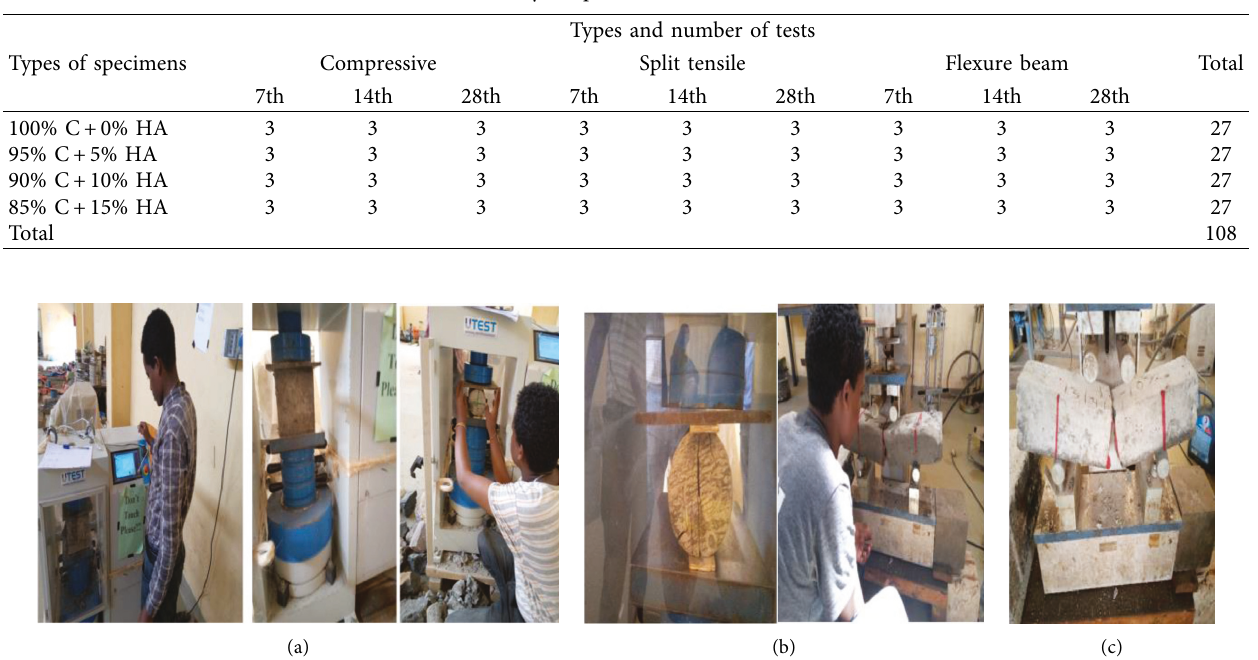
Figure 4: Casting concrete test specimens. Table 6: Summary of specimens for hardened concrete.